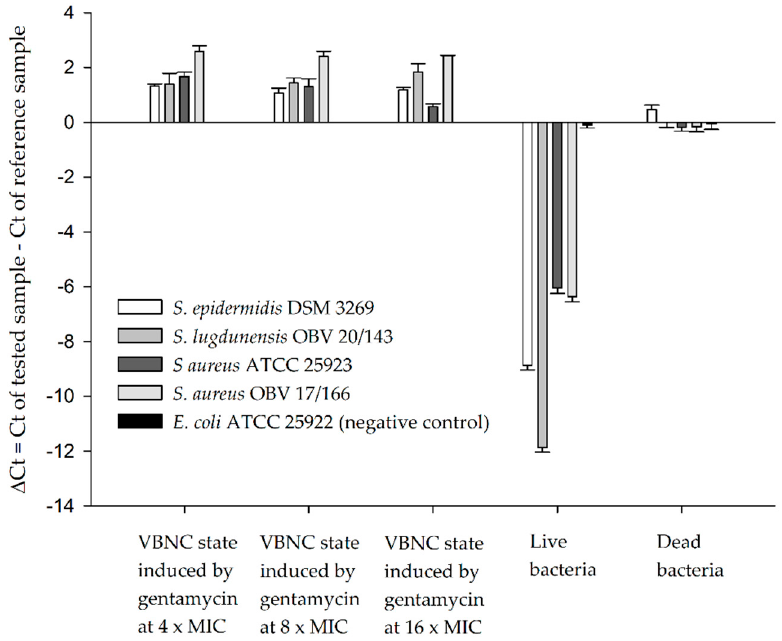
Figure 3. Detection of VBNC, live, and dead bacteria with bacteriophage K and qPCR. Values are expressed as mean ± SD.